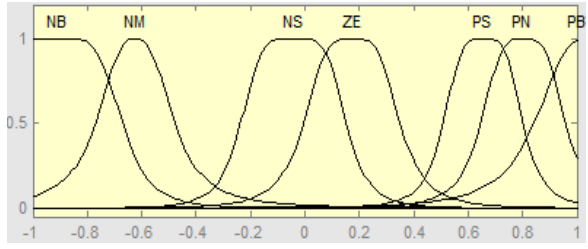
Figure 10. Membership functions of Qe(t-T) after training